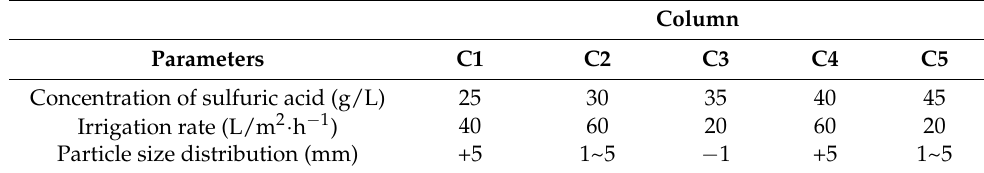
Table 1. The operational conditions for column leaching tests (Modified from [80]).